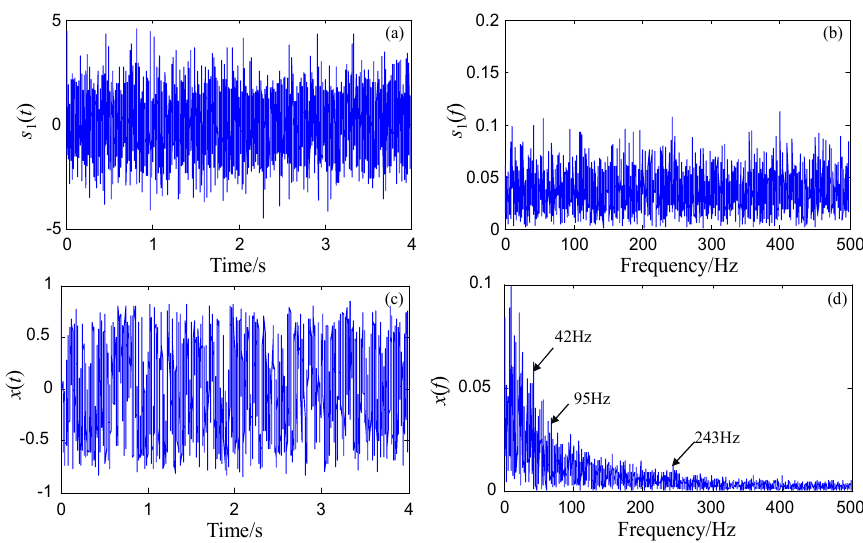
Figure 5. Signal processing based on Frequency Re-scaling Stochastic Resonance (FRSR). ( a , b ) are the time-domain waveform and frequency spectrum of the original signal; ( c , d ) are time-domain waveform and frequency spectrum of the response of the FRSR system with scale factor R = 200.